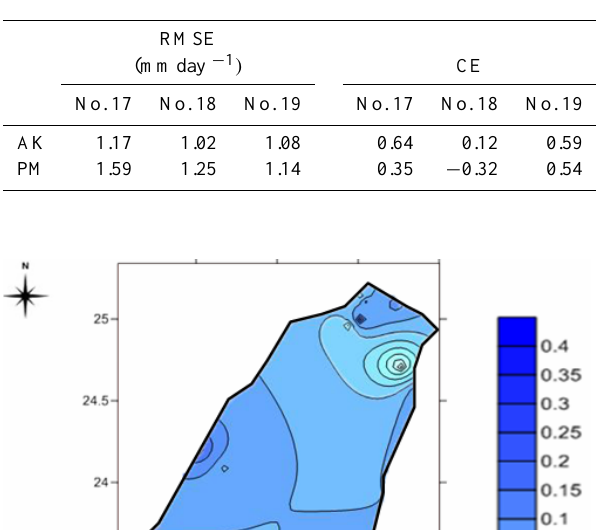
Performance of the ANFIS model in the training, validation and testing subsets.